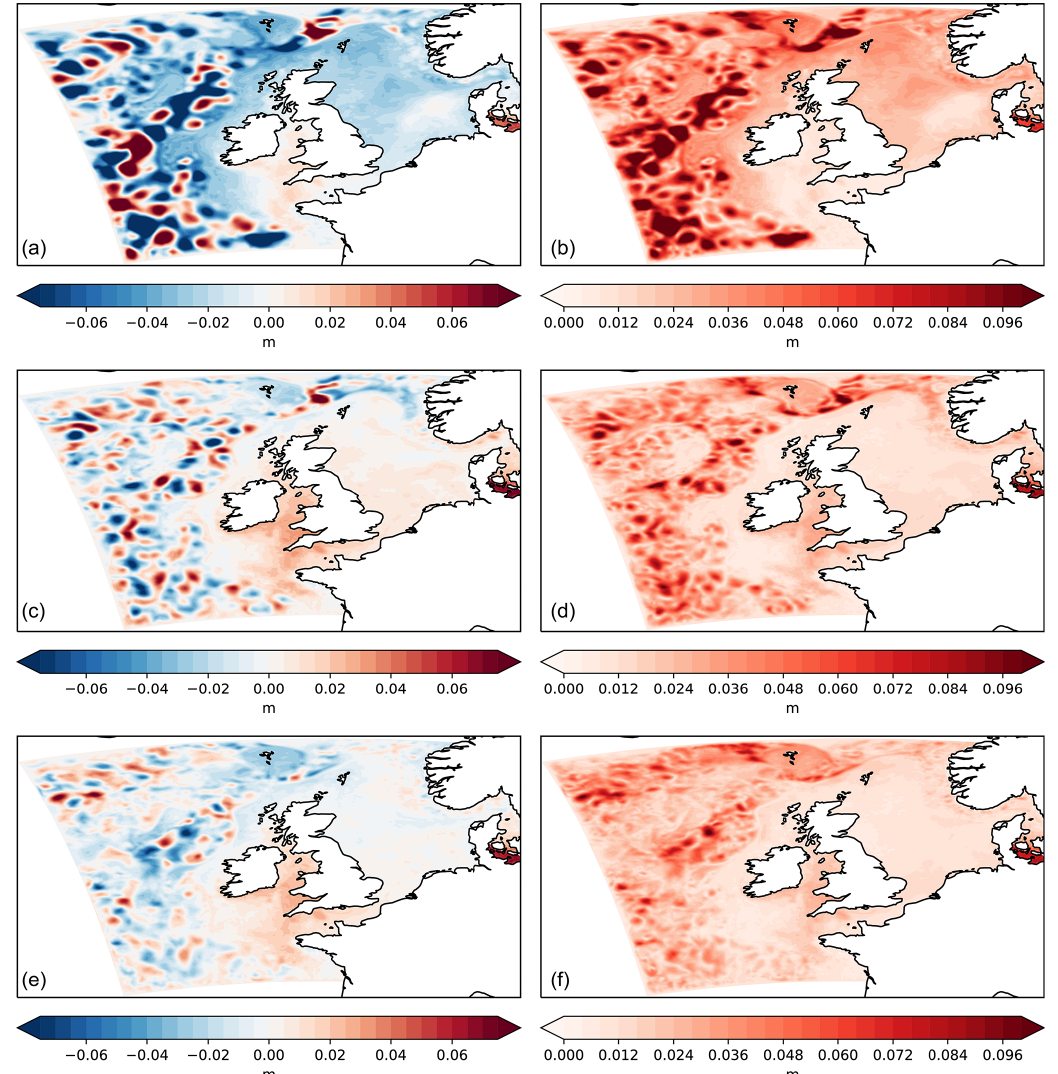
Figure 8. June 2018 average SSH bias (a,c,e) and RMSE (b,d,f) for the free run (ab) , control (cd) and LowErrSWOT experiments (ef) .